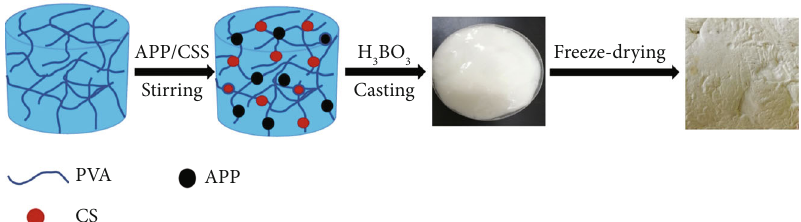
Figure 1: Preparation procedure of the PVA composite aerogel.